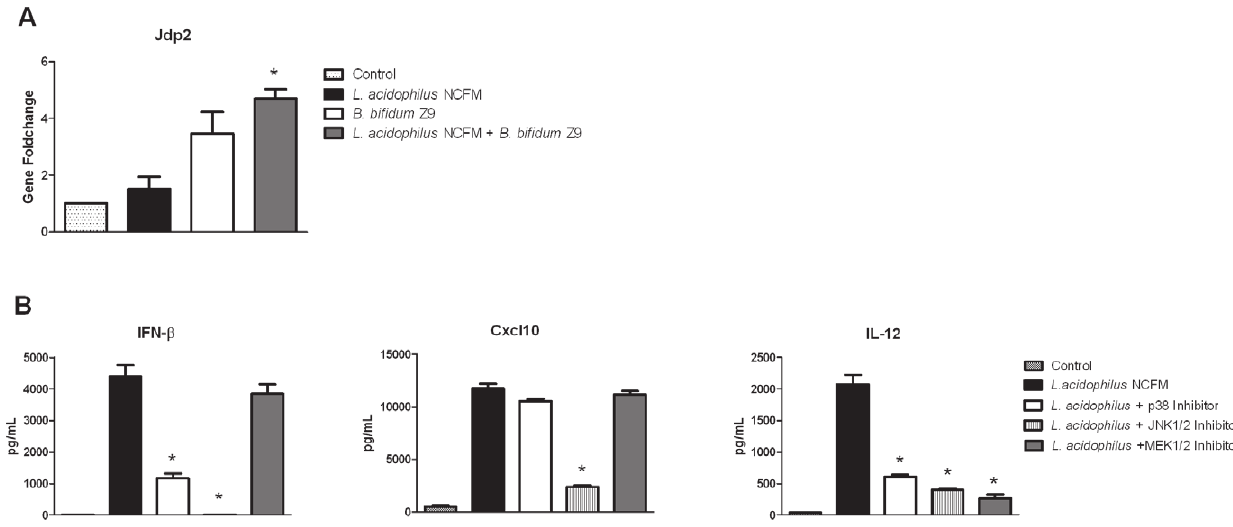
Figure 6. Jdp2 and MAPK kinases control immune responses in dendritic cells. Expression of Jdp2 and inhibition of MAPK kinases in dendritic cells upon stimulation of L. acidophilus NCFM. A . B. bifidum Z9 exerts an additive effect on the expression of Jdp2 in DC stimulated with L. acidophilus NCFM at timepoint 10 h measured by RT-PCR ( L. acidophilus NCFM + B. bifidum Z9 versus L. acidophilus NCFM, P , 0.01). B : Protein expression of IFN- b , Cxcl10 and IL-12 in murine L. acidophilus NCFM stimulated dendritic cells measured by ELISA in the presence of the MAPK inhibitors p38, JNK1/2 and MEK1/2 ( L. acidophilus NCFM versus inhibitors, P , 0.01).